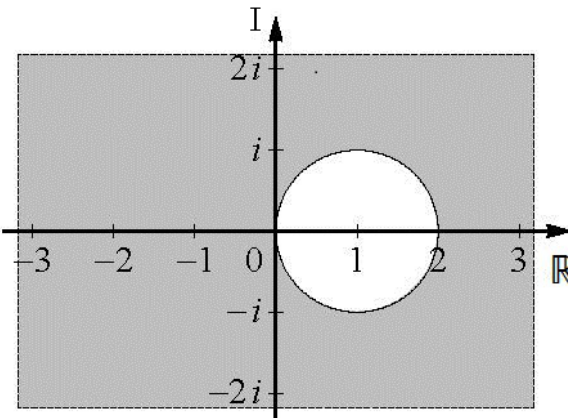
Figure 39: The gray region outside the disk shows the stability re- gion of the backward Euler method.